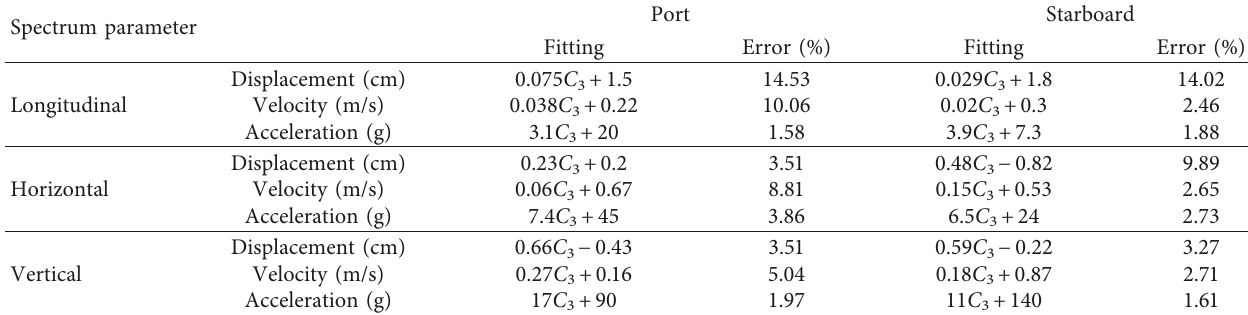
Figure 20: Linear fitting of the impact environment on the port Table 9: Fitting formula and error of spectral parameters.